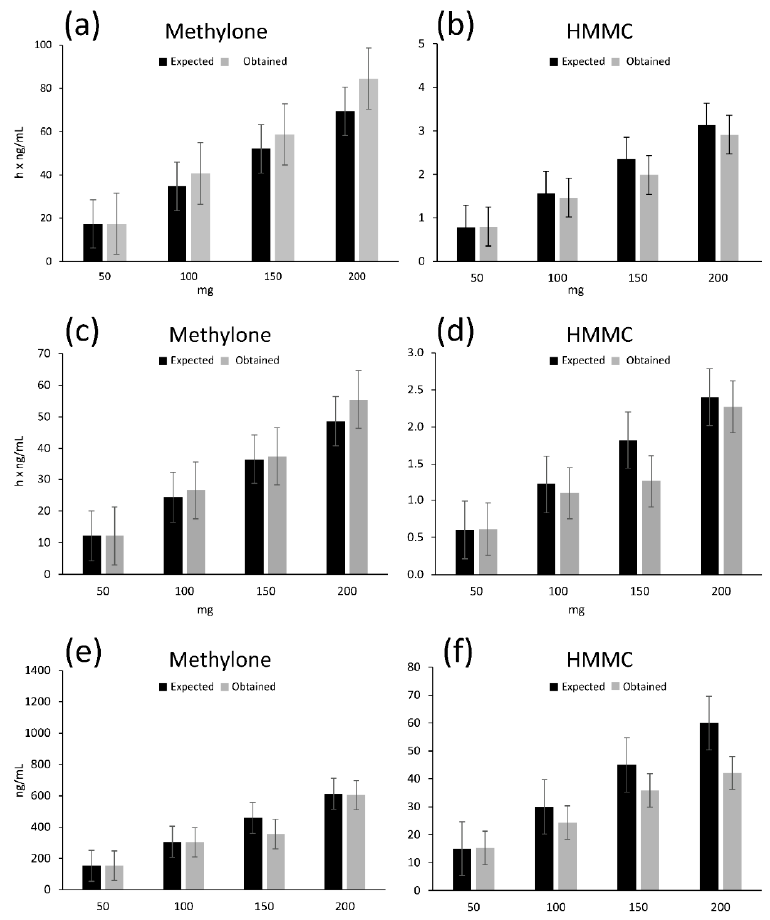
Figure 3. Comparison of expected vs. observed ( a , b ) area-under-the-curve 0–24 values (AUC0–24); ( c , d ) area-under-the-curve 0–10 values (AUC0–10); ( e , f ) maximum concentration (Cmax) values of methylone and HMMC, respectively. HMMC, 4-hydroxy-3methoxymethcathinone. For methylone’s metabolite HMMC, the Cmax values were 10 – 14-fold lower, the AUC0 – 10 values were 19 – 24-fold lower and the AUC0 – 24 values were 21 – 29-fold lower than those of methylone. HMMC Cmax occurred between 0.9 and 1.5 h. Clast concentra- tions were 0.5, 0.4, 1.3 and 0.8 ng/mL at 24 h, respectively. Cmax for the 100 mg oral MDMA dose was 66.1 ng/mL at 2.0 h (Tmax), AUC0 – 10 was 468.2 h*ng/mL and AUC0 – 24 was 888.6 h*ng/mL. For MDMA metabolites, MDA Cmax was 21.9 ng/mL after 4.0 h, AUC0 – 10 was 135.9 h*ng/mL and AUC0 – 24 was 290.8 h*ng/mL. HMMA Cmax was 85.6 ng/mL at a Tmax of 3 h and AUC0 – 24 was 294.1 h*ng/mL with a T1/2 value of 5.4 h and at 24 h, this reduced to a concentration (Clast) of 1.8 ng/mL. Finally, HMA Cmax was 20.8 ng/mL with a Tmax of 3 h and AUC0 – 24 was 71.0 h*ng/mL, with a T1/2 of 5.3 h and Clast of 0.7 ng/mL after 24 h. HMMC concentrations were approximately 20 times lower than methylone’s drug concentration, for all adminis- tered doses (50, 100, 150 and 200 mg), while HMA, HMMA and MDA concentrations were 8-, 2- and 8-times lower than MDMA’s concentrations, respectively. The relative concen- trations of MDMA and its metabolites were MDMA > HMMA > MDA > HMA. The dose response based on Cmax for the 50, 100, 150 and 200 mg oral doses of methylone resulted in dose-proportional values of 3.1, 3, 2.4 and 3, respectively, and based